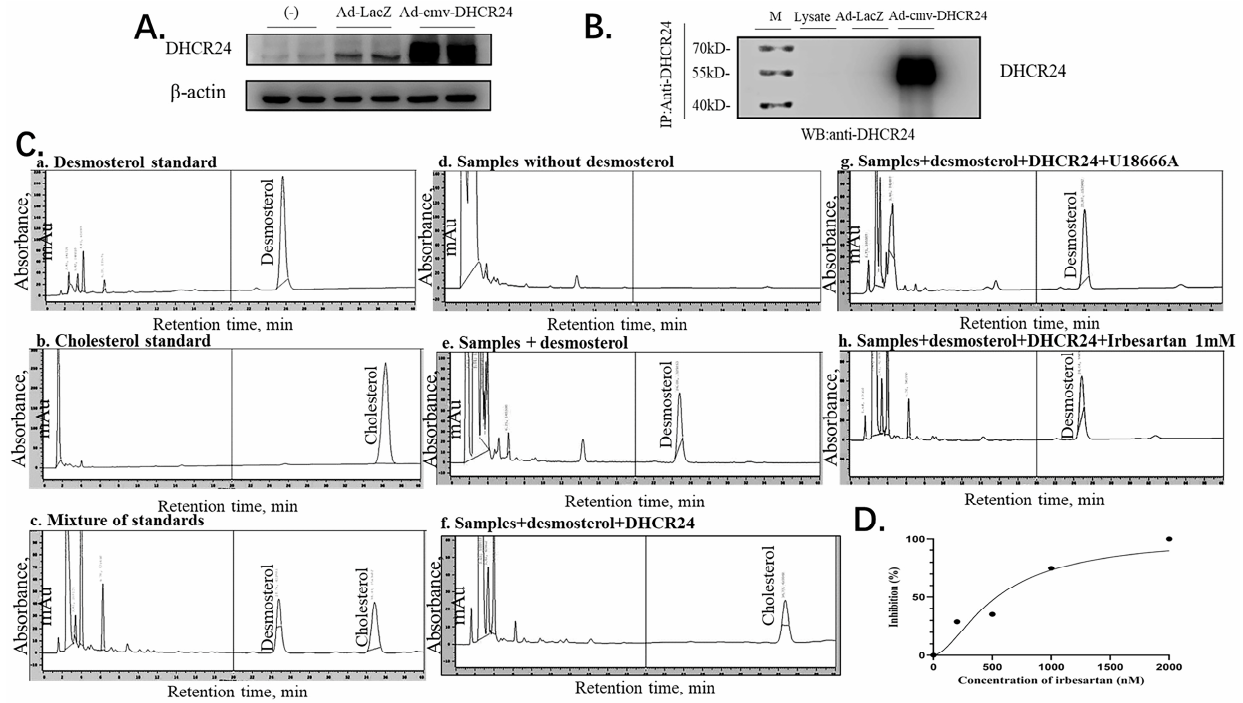
Figure 6. Irbesartan inhibits cholesterol synthesis in the immune complex-activity assay. ( A ) Western blotting indicates the amounts of β -actin and adenovirus-mediated overexpression of DHCR24 . ( B ) Western blots indicating the amounts of immunoprecipitated DHCR24 and β -actin. ( C ) HPLC chromatogram of desmosterol and cholesterol. The chromatographic conditions used were as follows: column, C18; mobile phase, methanol; flow-rate, 1 mL/min; detection, ultraviolet absorbance at 210 nm. ( D ) Correlation of the inhibition (%) of DHCR24 and the concentration of irbesartan (nM) R 2 = 0.9344.